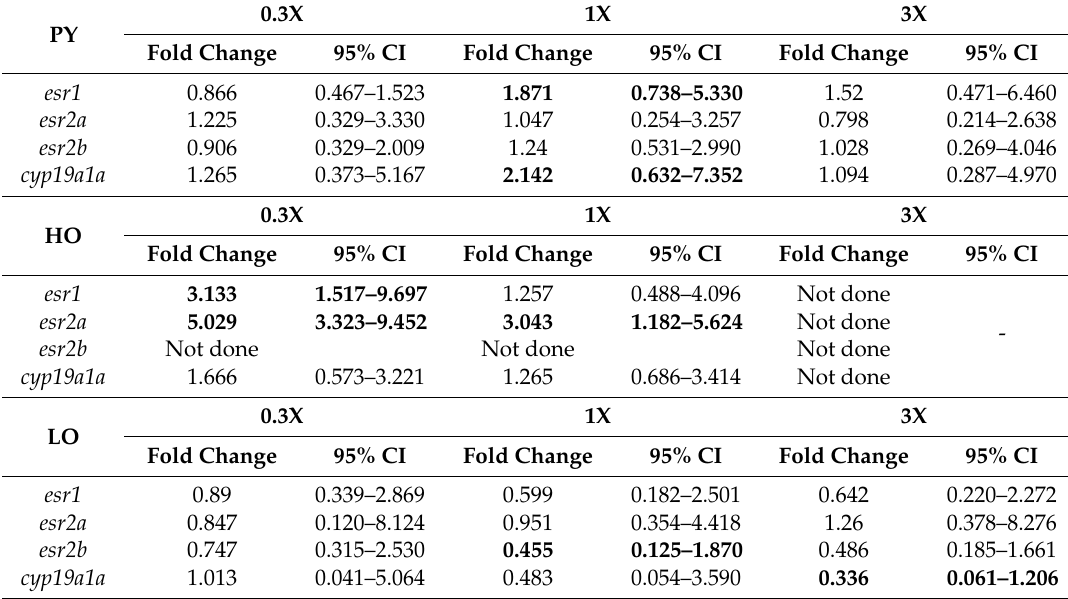
Table 2. qPCR genes expression analysis in ovary of exposed